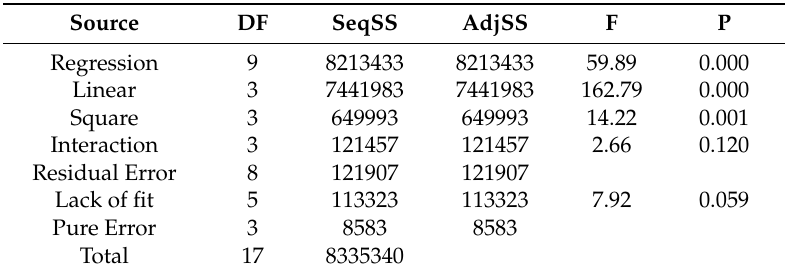
Table 3. Analysis of Variance for Logistics Cost.